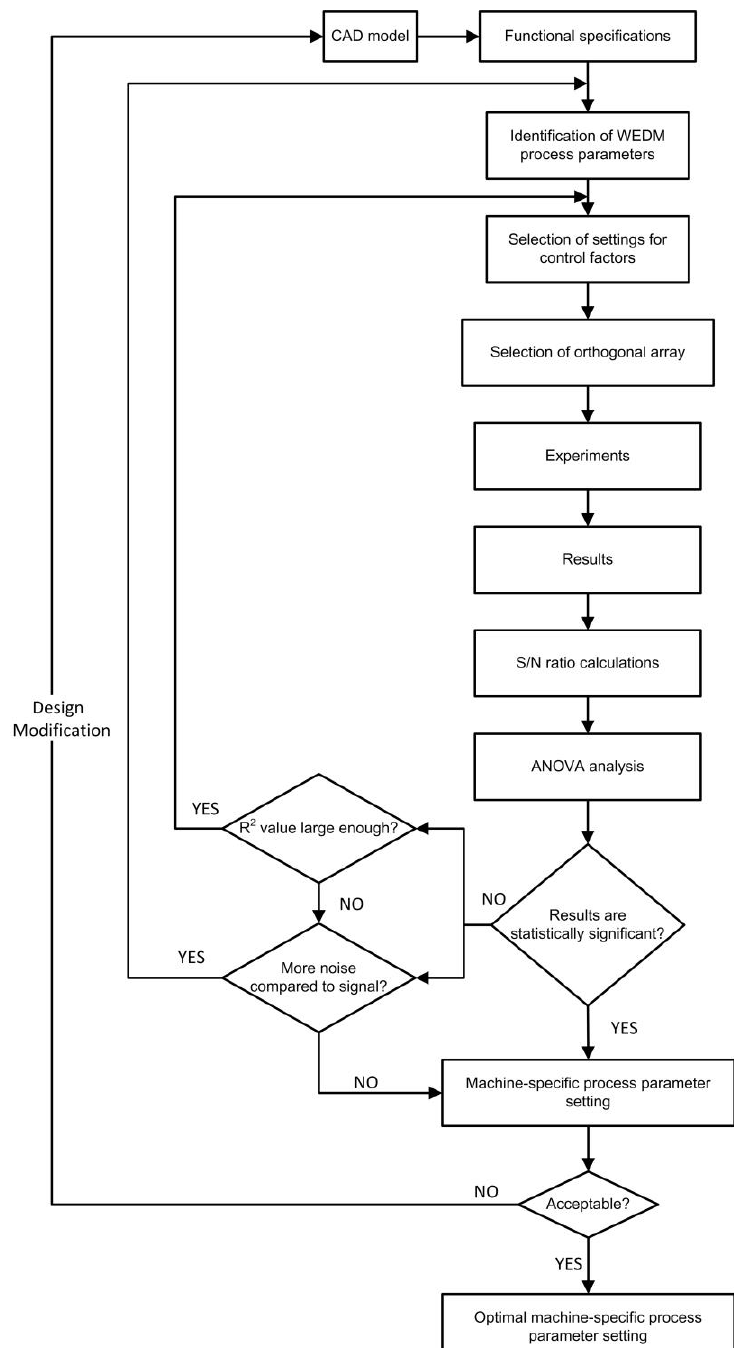
Figure 1. Proposed Methodology for selection of optimal process parameter settings (modified from Zaman et al. [43]).